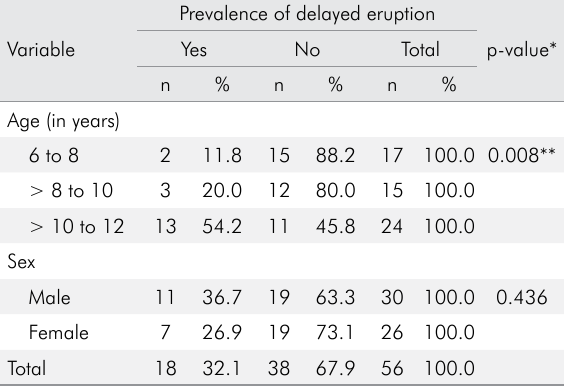
Table 4. Prevalence of delayed tooth eruption according to age and